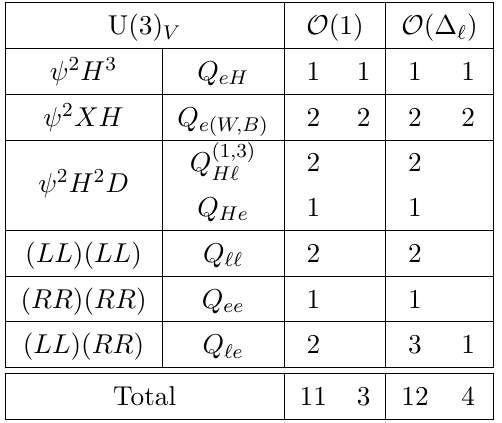
Table 12 . Counting of the pure lepton SMEFT operators (see appendix A) assuming U(3) vectorial symmetry in the lepton sector. The counting is performed up to one insertion of ∆ ‘ spurion. The left (right) entry in each column gives the number of CP even (odd) coefficients at the given order in spurion